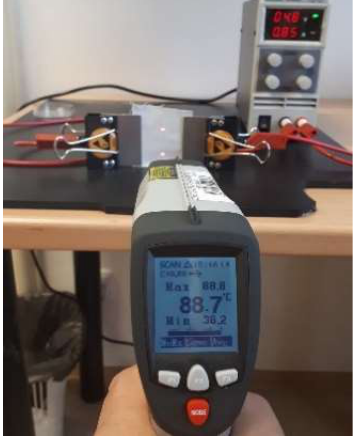
Figure 9. Generation of ohmic heat in a hybrid fabric.